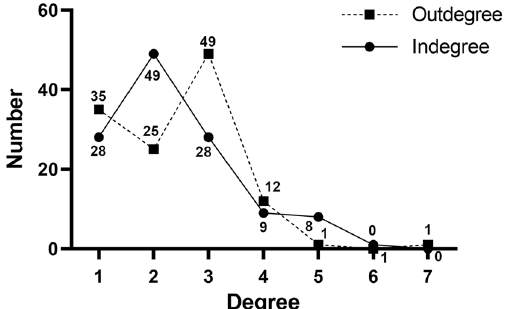
Fig. 4 Degree distribution of the